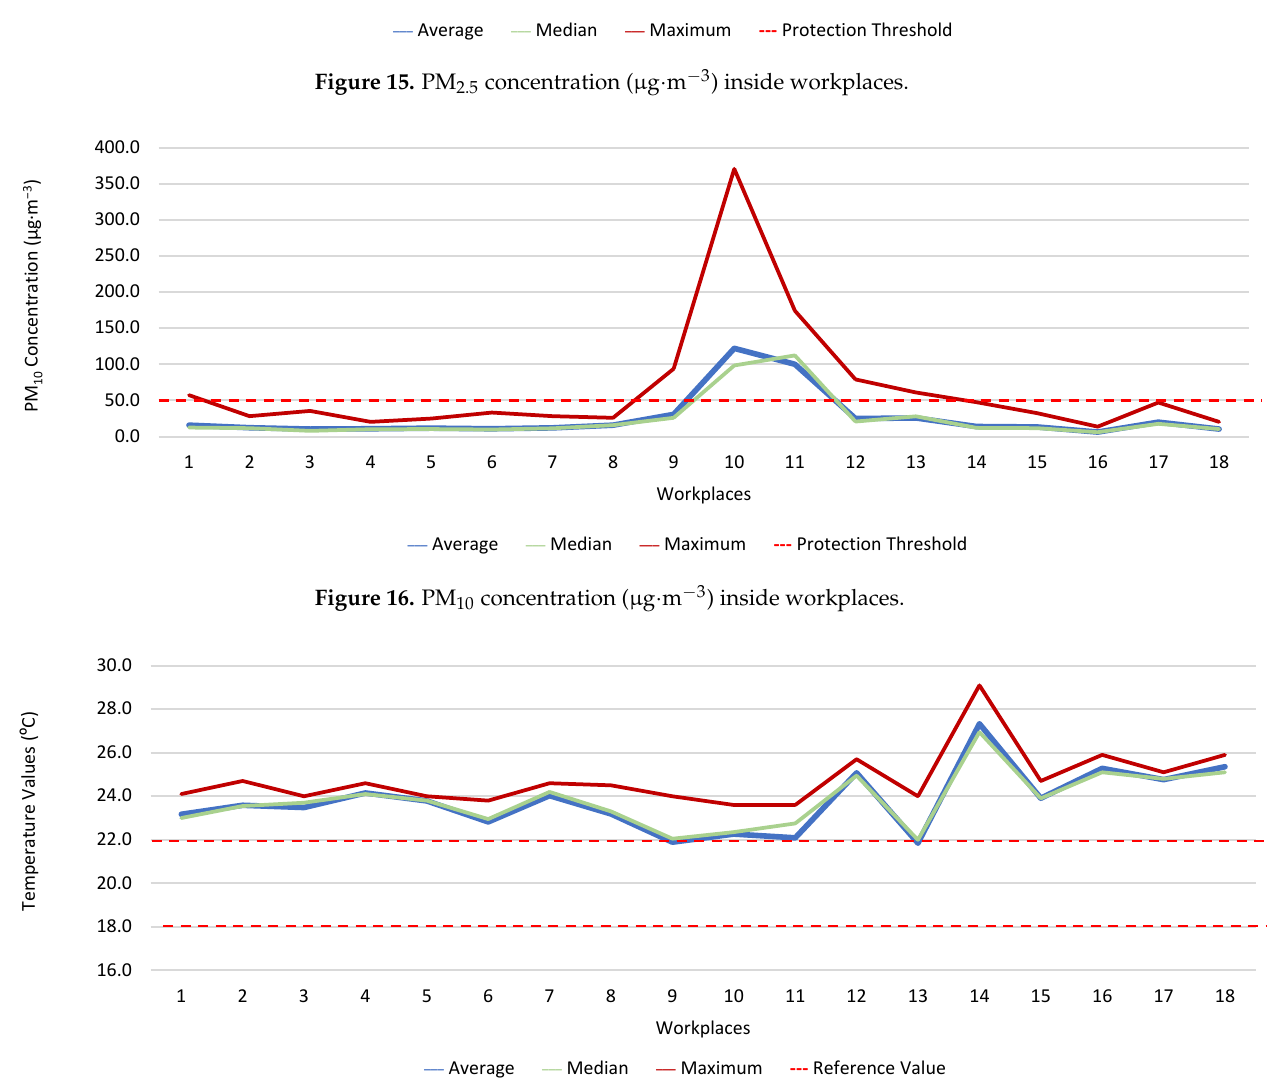
Figure 18. Relative humidity values (%) inside workplaces. Furthermore, it was decided to determine which workers experienced concentrations of pollutants that exceeded the legally established protection threshold. Thus, Table 3 shows the number of measurements for each of the parameters that have a stipulated pro- tection threshold and that, at some point in the evaluations, exceeded this threshold (max- imum values), putting the workers at risk. The analysis of Table 3 shows significant differences between the absence or presence of risk in the different offices and services where the workers performed their activities. In this sense, it was also found that the two workers who experienced high concentrations of CO 2 performed their duties in the same workspace, although, when applying the toler- ance margin, compliance was verified. In terms of PM 2.5 , 11 workers experienced high concentrations (in six workplaces), and there were six workplaces where the legal value of PM 10 was exceeded, and where 12 workers worked. When the tolerance margin for PM 2.5 was applied, it was met in only one workplace. As for PM 10 , when applying the tolerance margin, it appears that the margin of tolerance was met in four workplaces. All the workers were faced with high concentrations of CH 2 O in their workplaces, since the protection threshold value was exceeded in all of them.